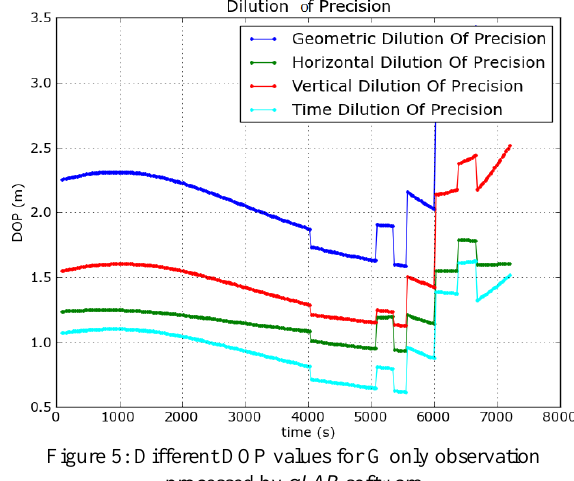
Figure 5: Different DOP values for G only observation processed by gLAB software